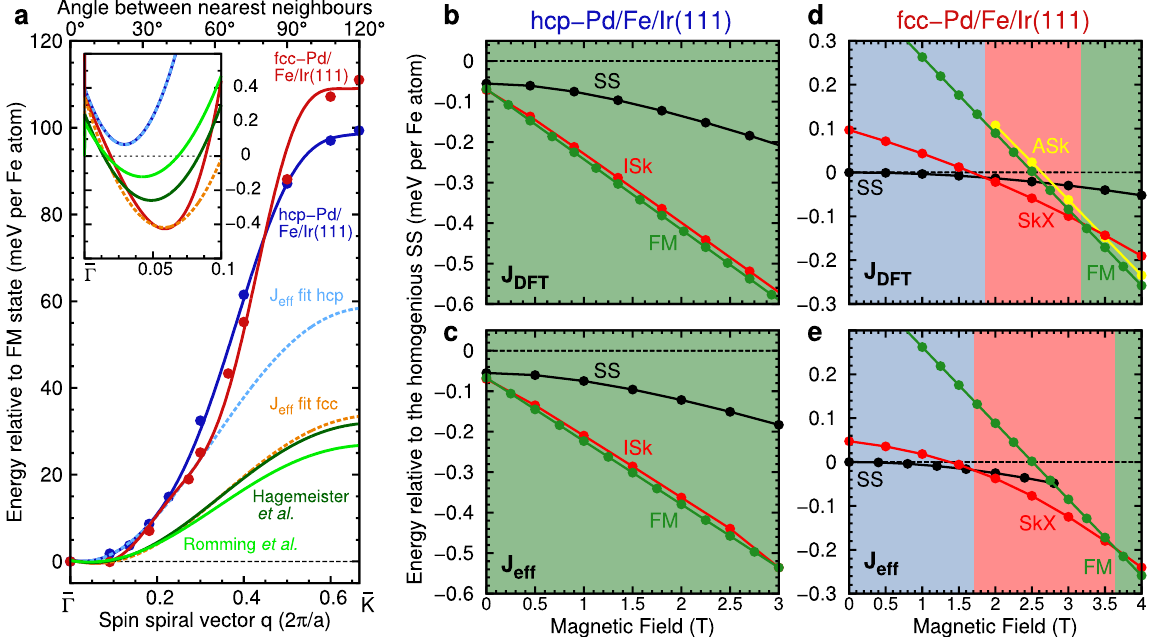
Figure 1. Energy dispersion of spin spirals and zero temperature phase diagrams of Pd/Fe/Ir(111). (a) Energy dispersion of homogeneous cycloidal right-rotating spin spirals for Pd/Fe/Ir(111) as a function of the spin spiral vector q along the Γ − K -direction. The inset shows a zoom of the dispersion around the energy minima. Note that there is an offset for all curves at q = 0 due to the magnetocrystalline anisotropy which leads to an energy increase for all spin spiral states of K /2 with respect to the ferromagnetic state. The filled circles are total energies obtained from DFT for fcc (red) or hcp (blue) stacking of the Pd layer including spin-orbit coupling. The solid lines are fits to the Heisenberg model including the Dzyaloshinskii-Moriya interaction. The dashed lines are fits to the DFT energy dispersion close to the energy minima with an effective nearest-neighbor exchange interaction J eff and effective DMI for fcc (orange) and hcp (blue) stacking. For comparison, the energy dispersions for parameters given by Romming et al . 24 (light green) and Hagemeister et al . 26 (dark green) are shown. (b,c) Zero temperature phase diagram for hcp-Pd/Fe/Ir(111) obtained with the DFT ( J DFT ) and effective ( J eff ) parameters, respectively. The energies of the ferromagnetic (FM), isolated skyrmion (ISk) and relaxed spin spiral (SS) state are shown relative to the homogeneous spin spiral (dashed line). The green color indicates the regime of the FM ground state. (d,e) Zero temperature phase diagram for fcc-Pd/Fe/Ir(111) as in (b,c) including the skyrmion lattice (SkX) and the isolated antiskyrmion (ASk) state. Blue, red, and green color represents the regime of the SS, SkX, and FM ground state, respectively.